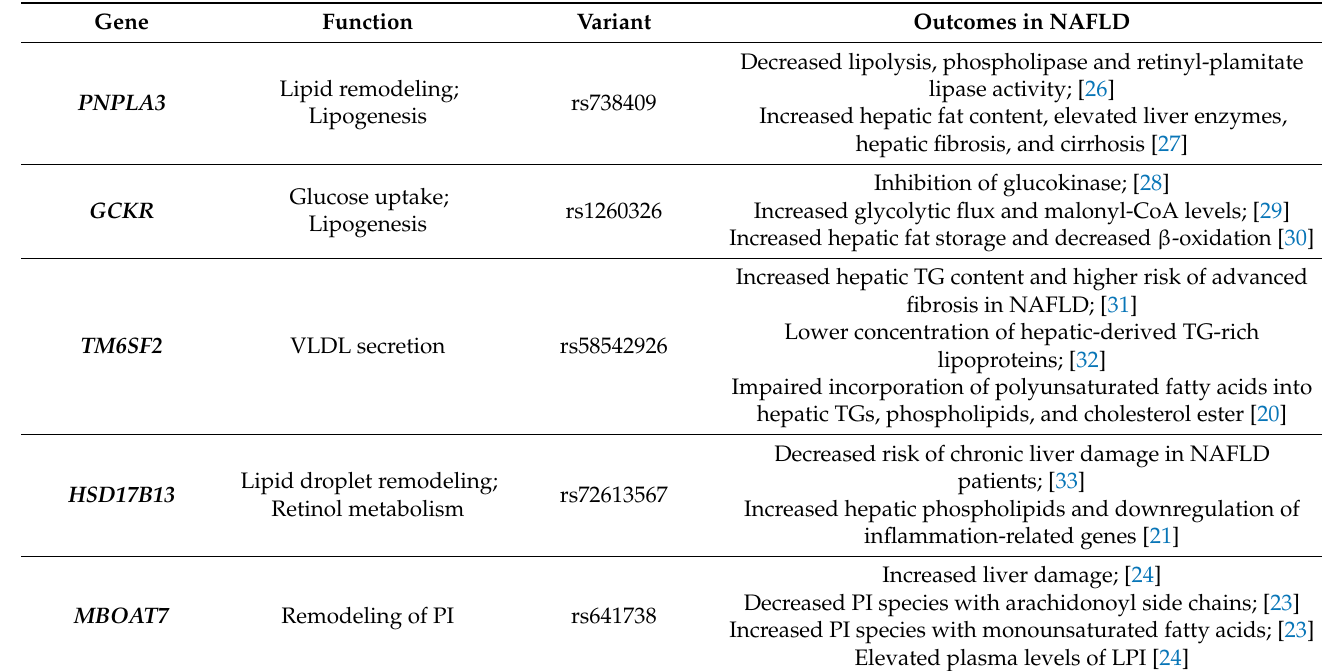
Table 1. Expression patterns and function of genes associated with NAFLD